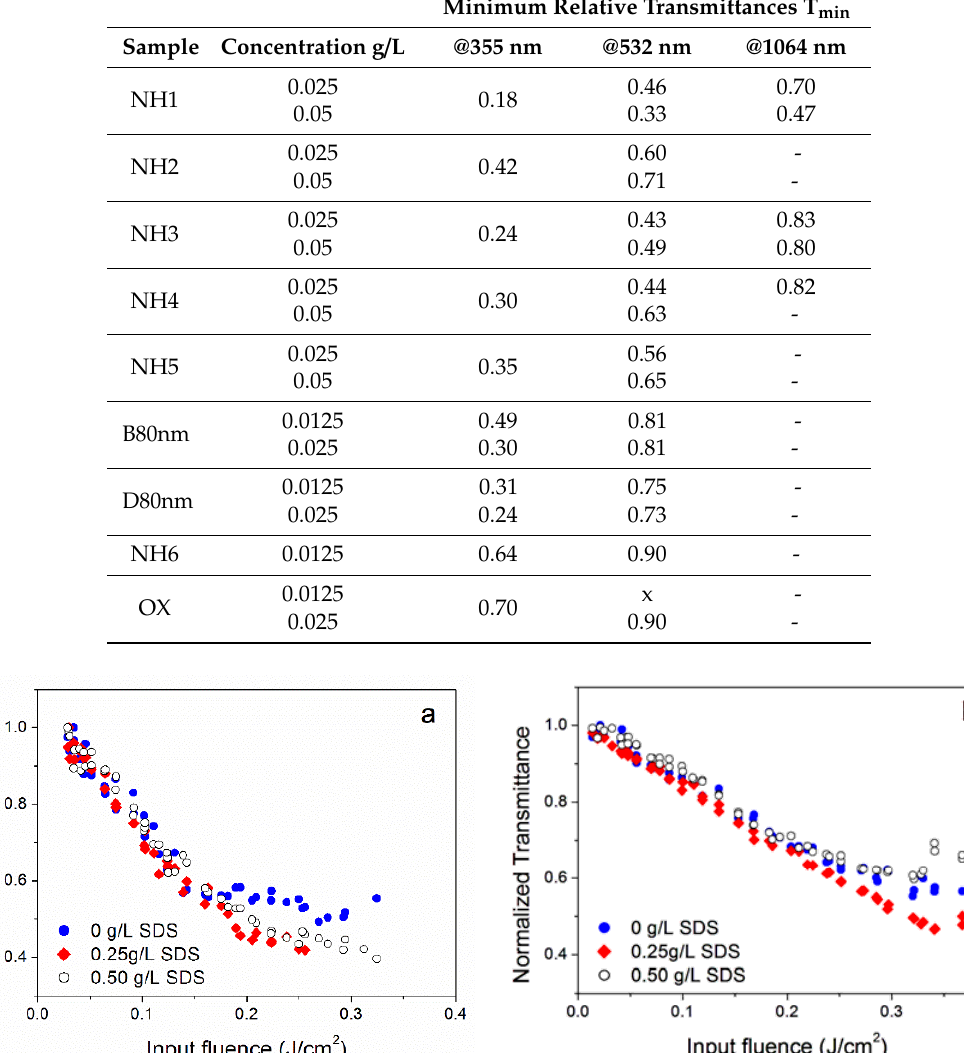
Table 3. Obtained minimum transmittances at di ff erent wavelengths. The symbol “-” refers to the cases where the sample damage prevented quantitative measurements, and the symbol x to the cases of no optical limiting. For the 355 nm wavelength, due to the high linear absorption, which consistently reduced the amount of transmitted radiation below the detection limit of our apparatus, even in the linear regime, the characterization was possible only at the lowest concentration.